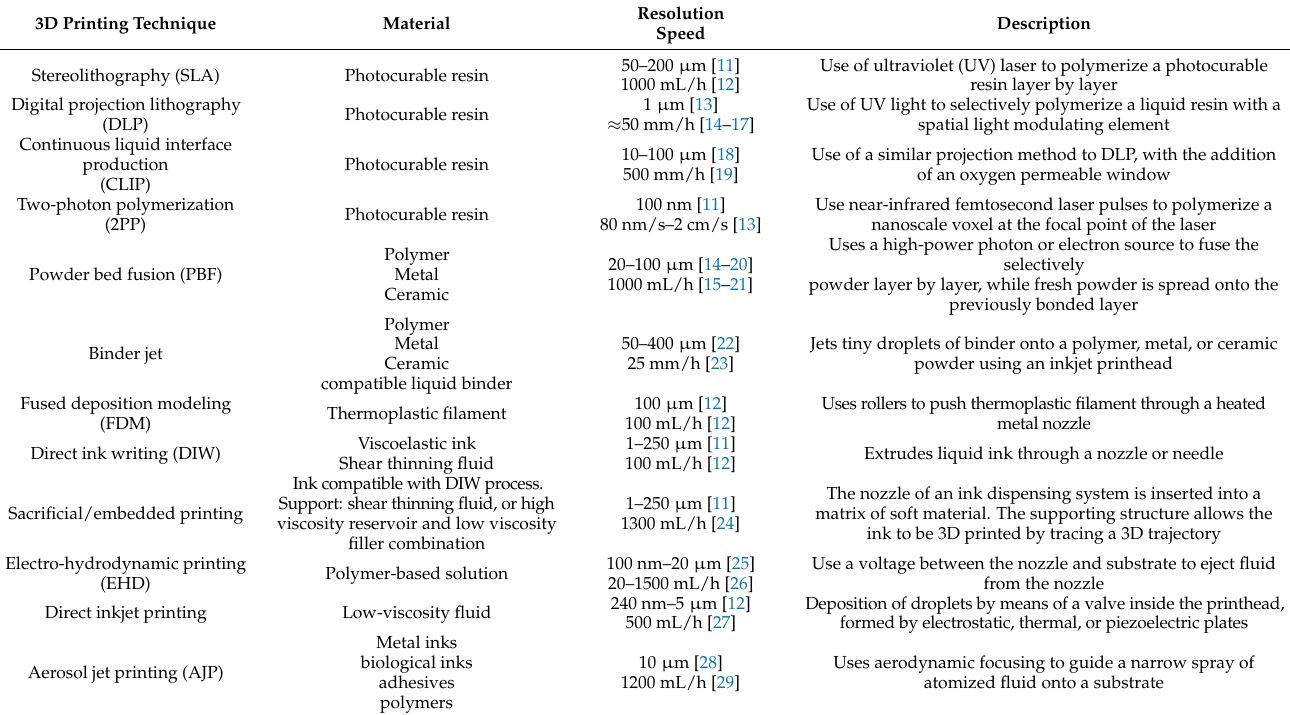
Table 1. 3D printing techniques with its basic characteristics